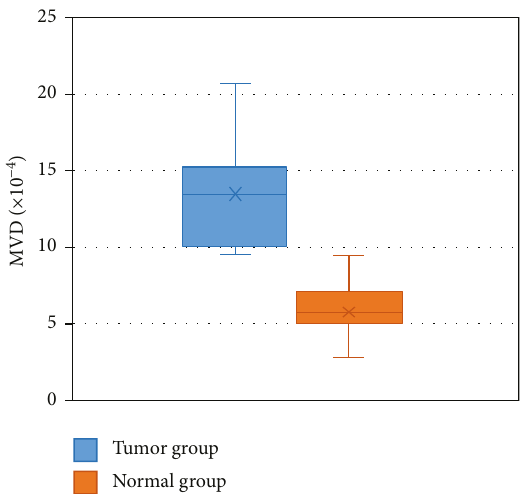
Figure 4: MVD statistics of the two sample groups.